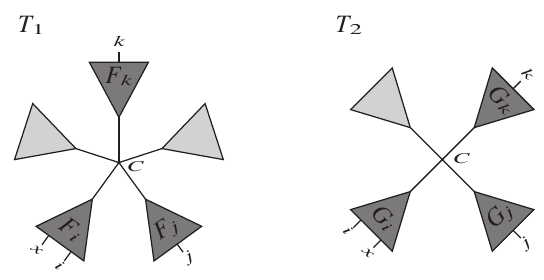
Figure 7. Computing quartets between high-degree